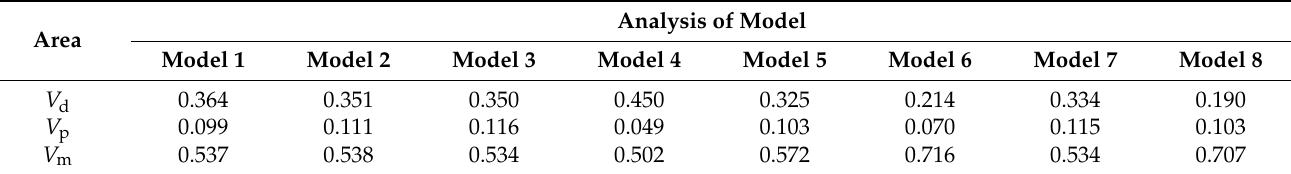
Table 2. Volume fraction results by Models 1 to